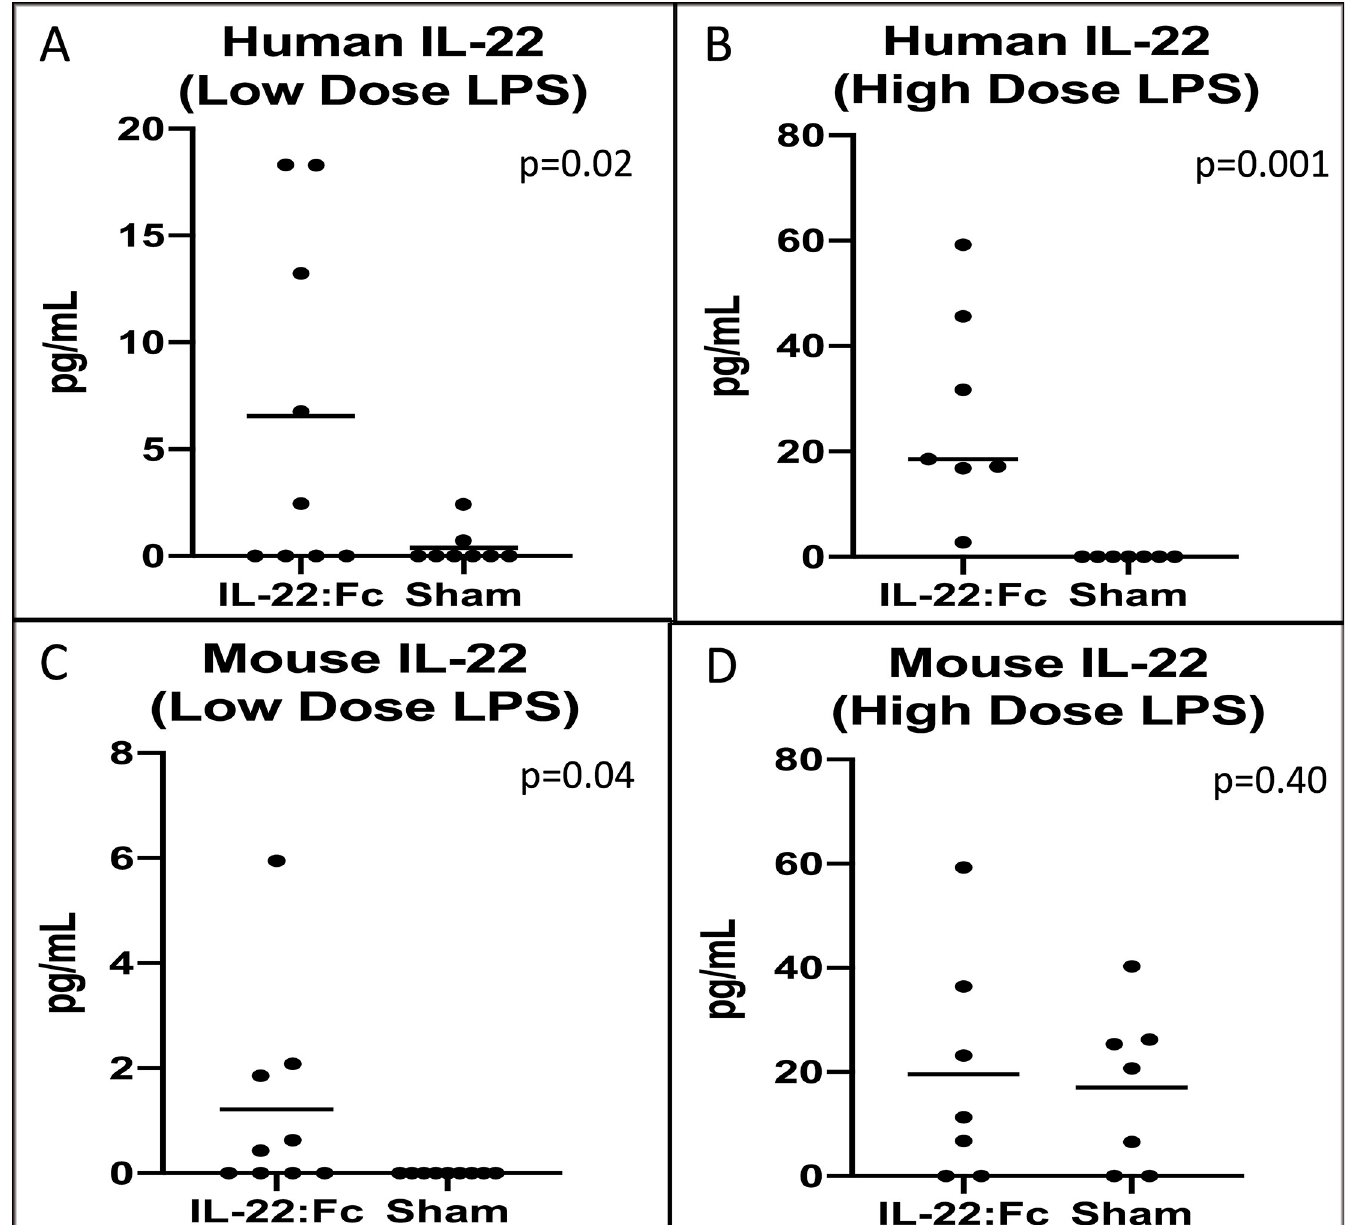
Fig 6. A comparison of exogenous and endogenous Interleukin-22 in the lungs. Because fk-652 is a human protein, we are able to differentiate between exogenous IL-22:Fc and endogenous IL-22:Fc. Treatment with IL-22:Fc appears to result in increased endogenous mouse IL-22 (C). Exogenous human IL-22 was detected in the BAL of treated mice (A and B) demonstrating that exogenous IL-22:Fc is reaching the lung. D) Endogenous mouse IL-22:Fc was not increased in IL-22:Fc treated after high-dose LPS injury. https://doi.org/10.1371/journal.pone.0254985.g006 Differentially expressed pathway genes for extracellular matrix-receptor interactions were also different between groups (Fig 9B). Tenascin C (Tnc), collagen, type I, alpha 1 (Col1a1), colla- gen, type VI, alpha 3 (Col6a3), and collagen, type I, alpha 2 (Col1a2) expression was increased with IL-22:Fc treatment (p = 0.003). IL-22:Fc treatment resulted in a decrease in Interleukin- 12a and Macrophage Inflammatory Protein-1 β (CCL4) transcription (p = 0.01).